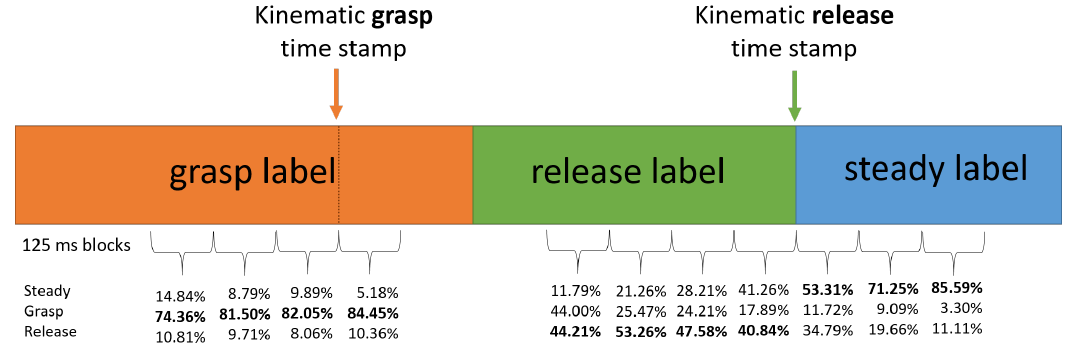
Figure 8. Enlarged version of the timeline from Figure 3, showing how often an epoch was classified as a given label for non-overlapping 125 ms windows close to kinematic time stamps for all trials in a five-component HMM unigram case. Bold numbers indicate correctly-classified regions.